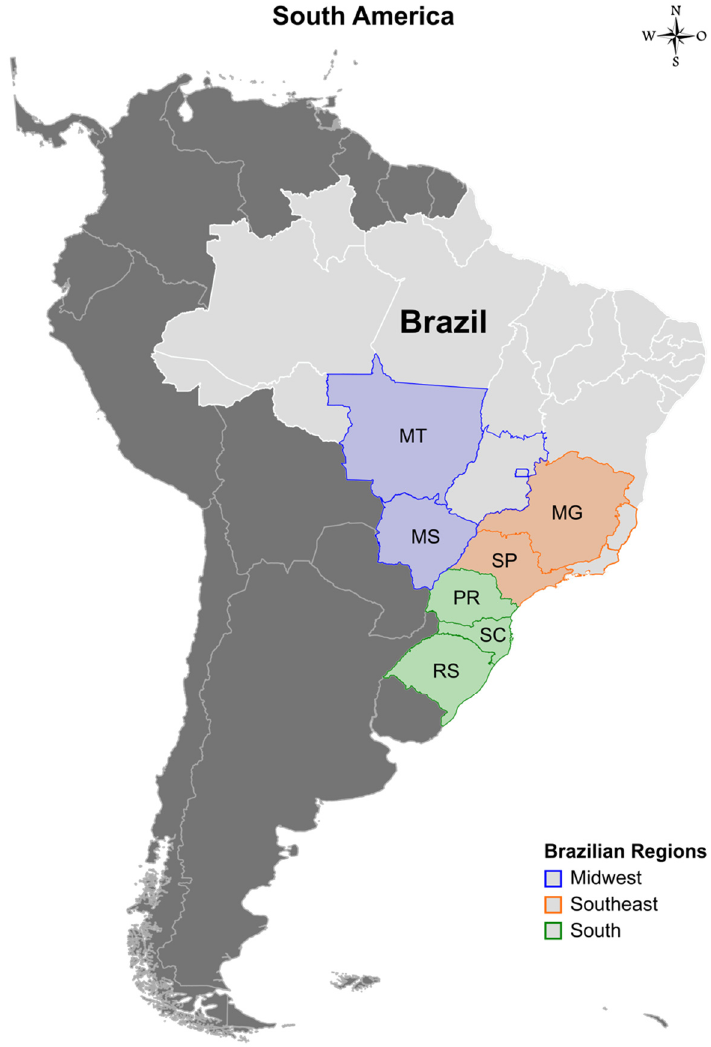
Figure 1. Map showing the three Brazilian regions (Midwestern, Southeastern, and Southern) and the seven states where samples were collected (color-filled): Mato Grosso (MT) with ~2.9 million pigs, Mato Grosso do Sul (MS) with ~0.69 million pigs, Minas Gerais (MG) with ~3.3 million pigs, São Paulo (SP) with ~1.3 million pigs, Paraná (PR) with ~5.8 million pigs, Santa Catarina (SC) with ~7.9 million pigs, and Rio Grande do Sul (RS) with ~6.2 million pigs.